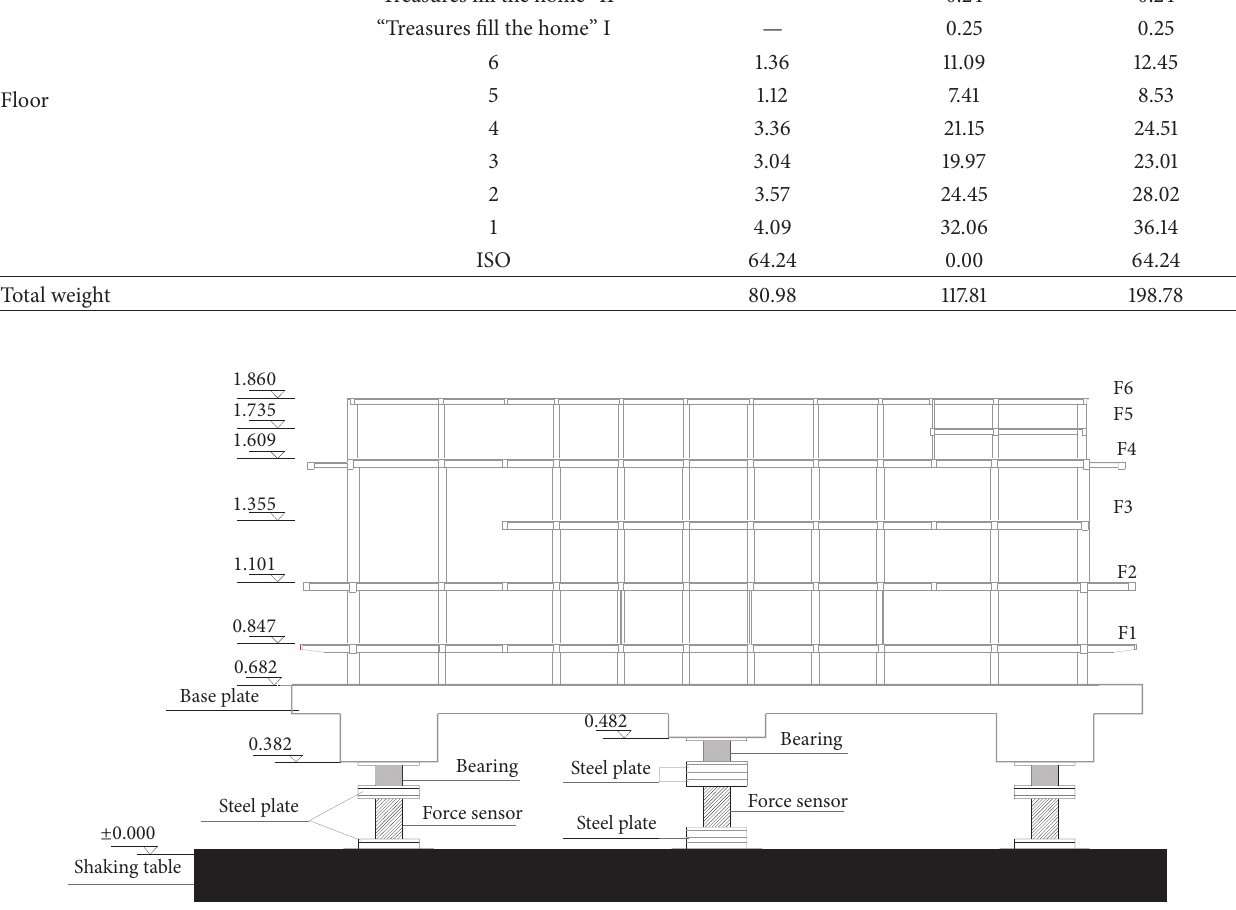
Figure 6: Shaking table test model for the isolated structure (unit: mm).